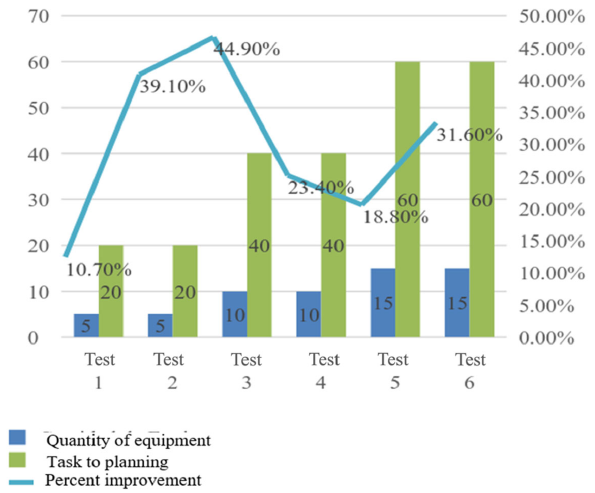
Figure 5. Differences of improvements obtained in the